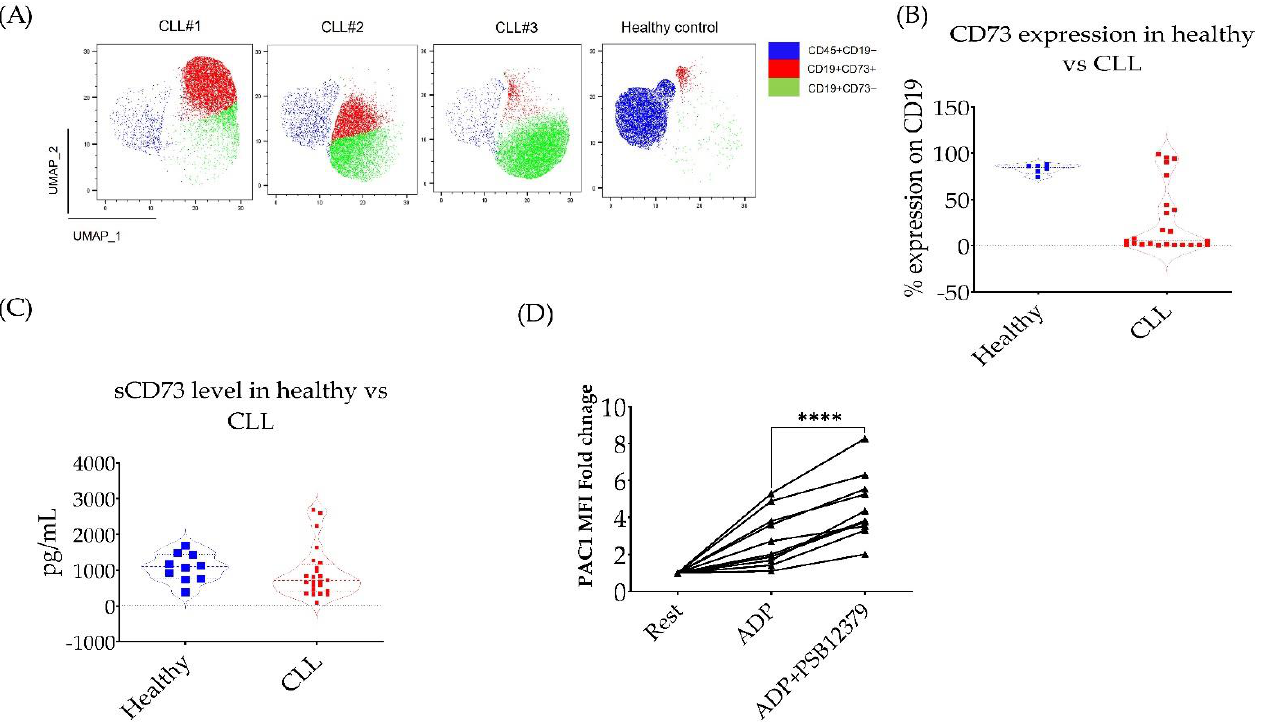
Figure 3. Low platelet response to ADP is partially improved by CD73 inhibition. ( A ) Repre- sentative UMAPs of CD73 expression in three different CLL patients and age-matched healthy control. ( B ) Combined data of CD73 expression on CD19 B-cells in the peripheral blood of CLL patients (red, n = 23) and age-matched healthy volunteers (blue, n = 6). ( C ) Soluble CD73 in the plasma of CLL patients (red, n = 23) and age-matched healthy volunteers (blue, n = 12). ( D ) The effect of CD73 inhibition on ADP-induced platelet activation in whole blood obtained from CLL patients, n = 10. Blood was incubated with the CD73 inhibitor (PSB12379. 10 µM) or vehicle control for 1 h, then ADP (2 µM) was added and platelets were further incubated for 15 min. Platelets’ activity was then assessed using flow cytometry and PAC1 antibody which only detects the activated platelet glycoprotein receptor αIIbβ3. UAMP (Uniform Manifold Approximation and Projection) was generated using FlowJo. **** p < 0.0001